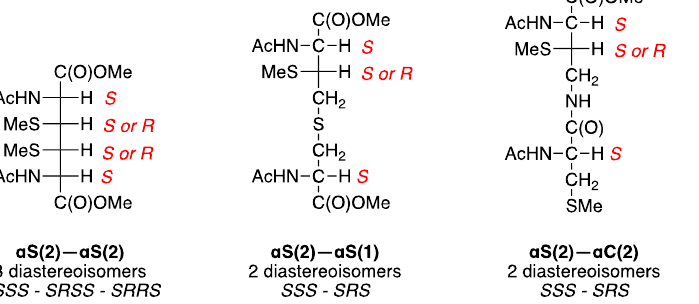
Figure 6. The chemical structures of α S(2)— α S(2), α S(2)— α S(1) and α S(2)— α C(2) identified in the radiolysis study of starting material 2 ; the configuration of stereocenters are indicated in